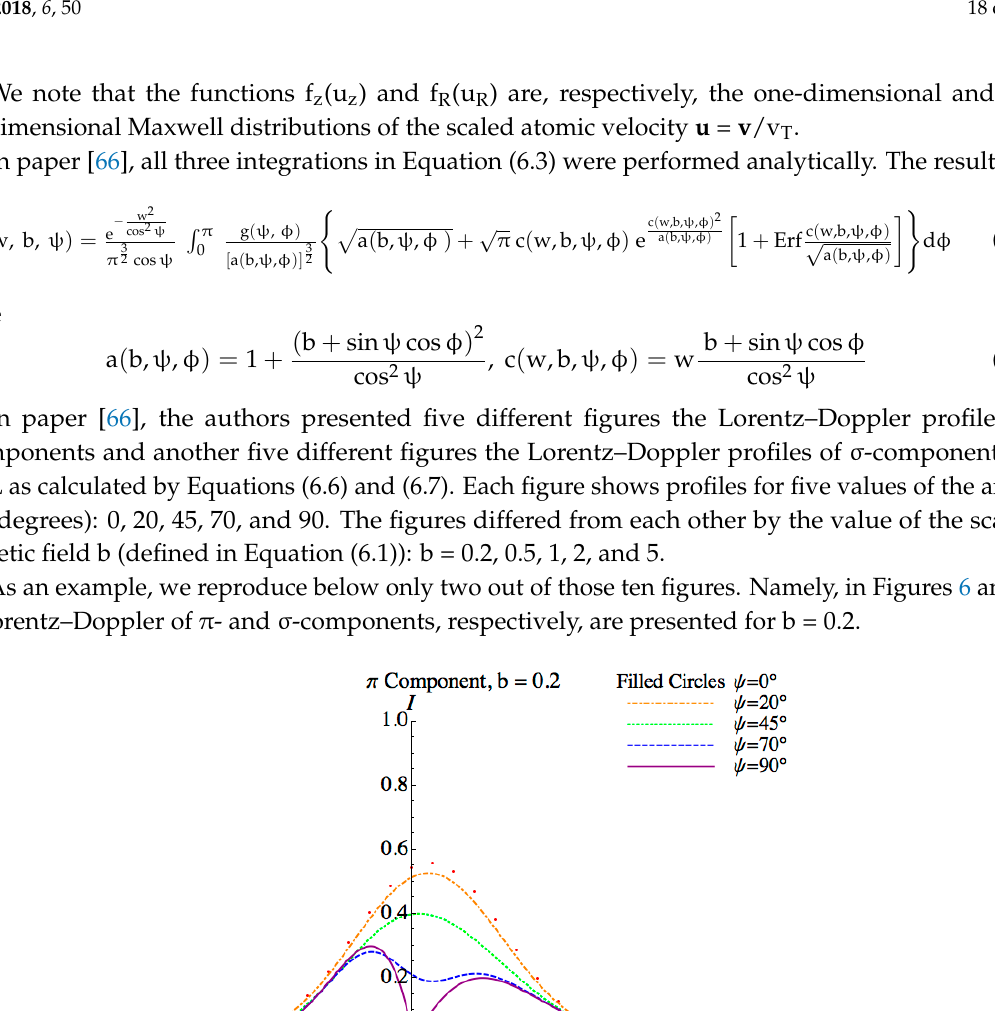
Figure 6. Lorentz–Doppler profiles of π -components of highly-excited hydrogen/deuterium spectral lines calculated by Equations (6.6) and (6.7), for the scaled magnetic field b = 0.2 (defined in Equation (6.1)) at five different values of the angle of observation ψ with respect to the magnetic field [66].